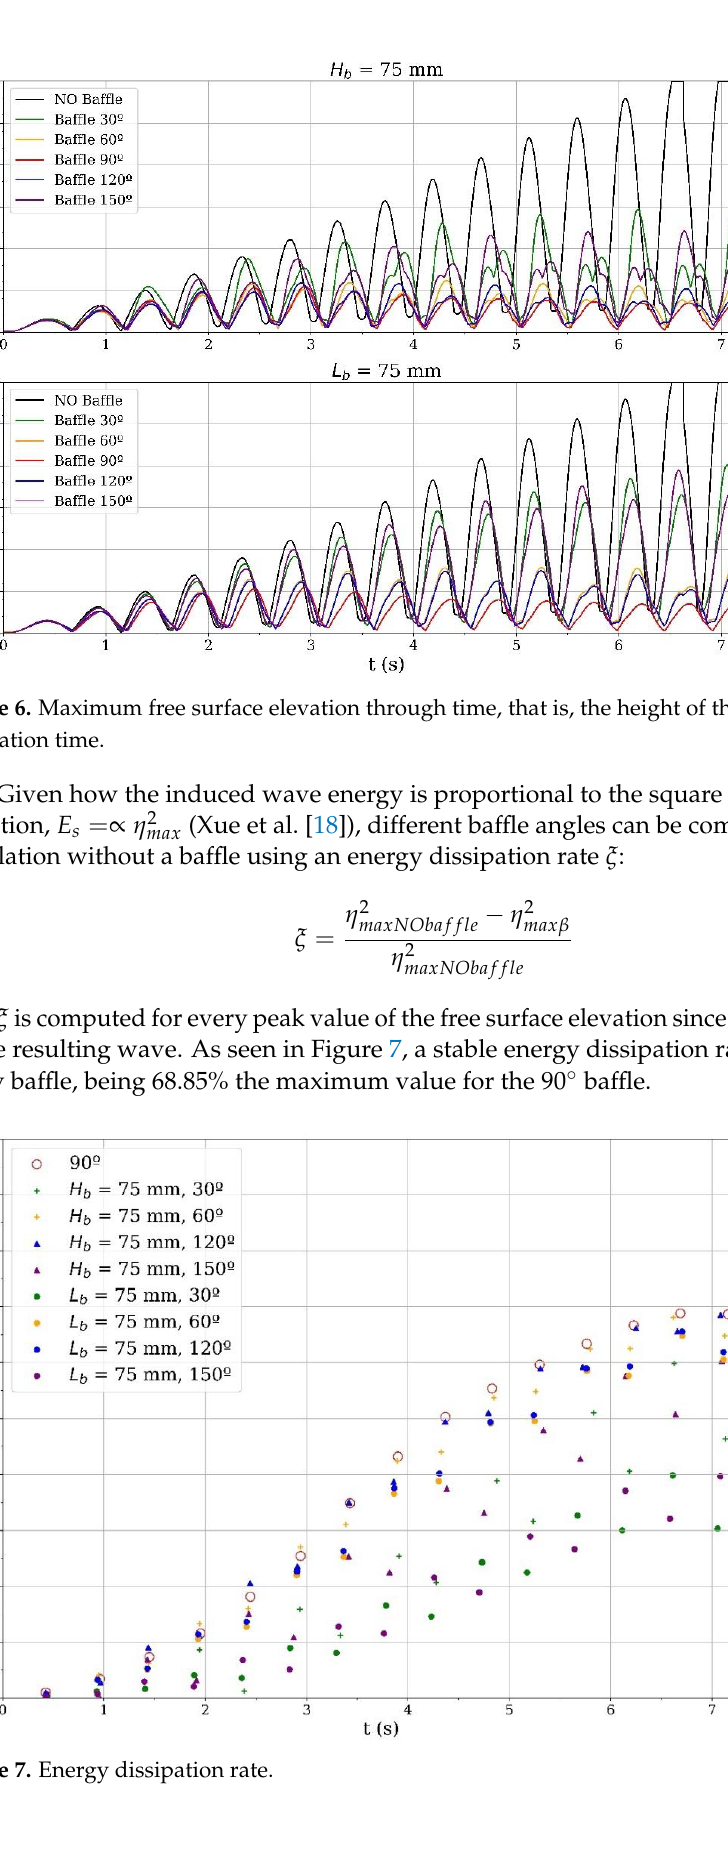
Figure 5. Free surface elevation at WG3. The solid line represents the simulations where H b = 75 mm, the dotted line where L b = 75 mm.